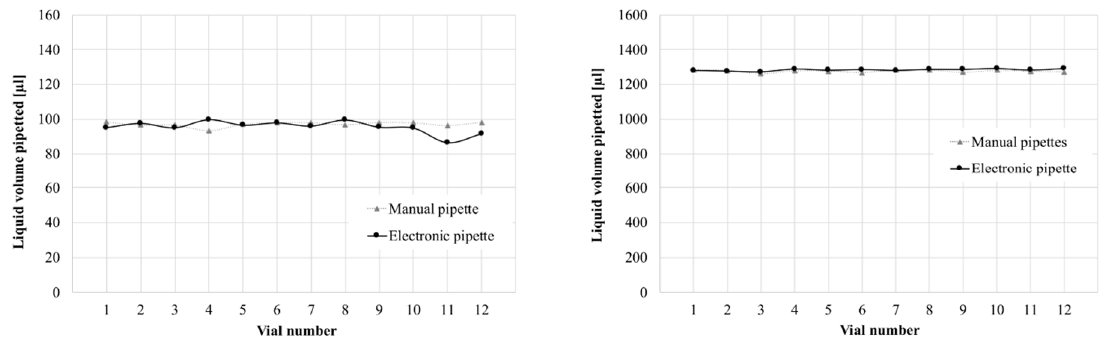
Figure 14. Comparison of measurement results: ( left ) Pipetting 100 µL using one manual and one electronic pipette; ( right ) pipetting 1300 µL using three manual pipettes and one electronic pipette.